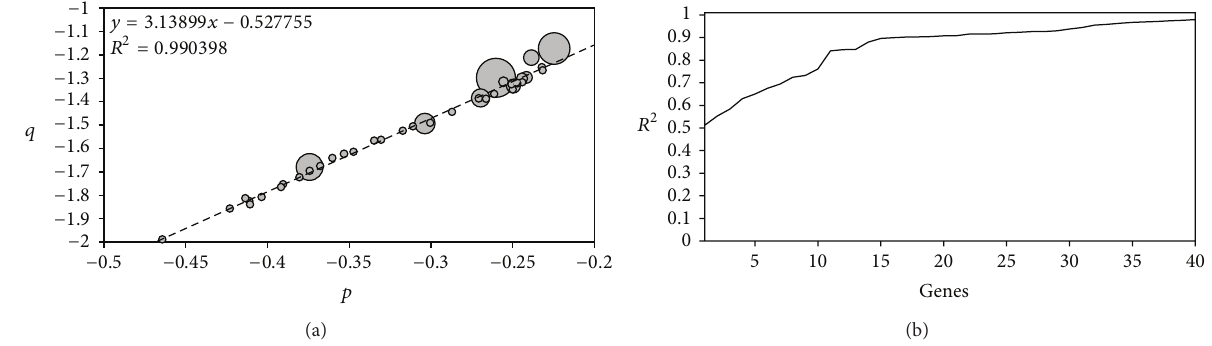
Figure 9: (a) Trend-line regression of the locus (𝑎,𝑏) of 40 genes from 27204 2-tuple HSRFs in Dataset 1. 𝑅 2 = 99.0 %. (b) Distribution of 𝑅 2